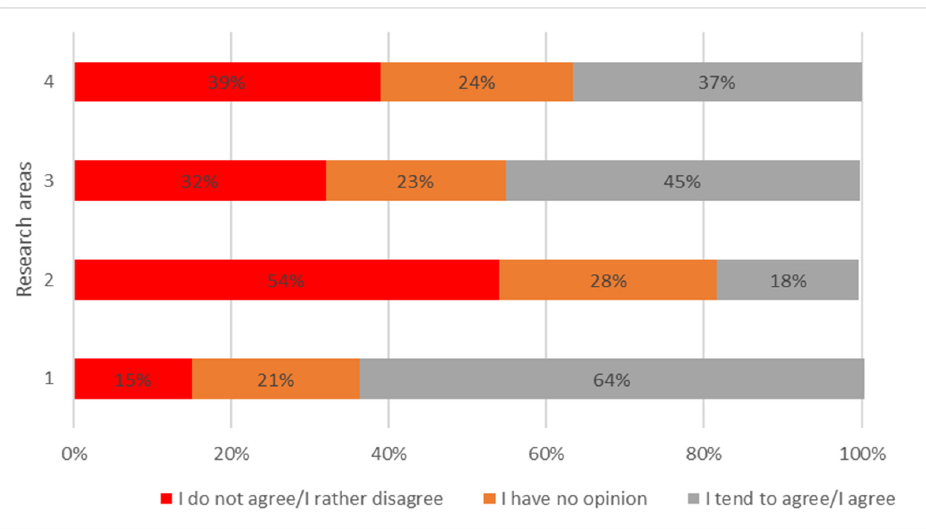
Figure 1. Percentage distribution of respondents’ answers in individual research areas 1–4. (1) Readi- ness to report to work in the event of a workplace disaster; (2) Willingness to work overtime in the event of a disaster, even without payment; (3) Willingness to take health risks when caring for people who are infectious or exposed to hazardous substances; (4) Willingness to transfer to other departments when disaster relief is